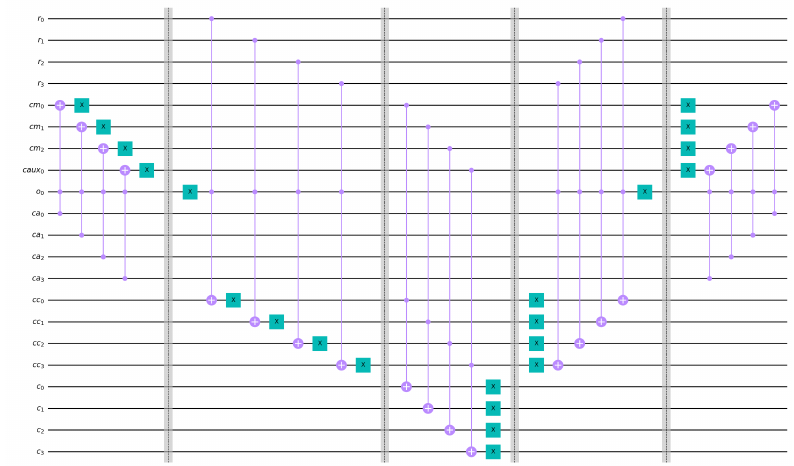
Figure 20. Selection circuit of expression (26), where the | ca (cid:105) qubits yield the computed y and | c (cid:105) stores the final output r (cid:48) . The last two sections of the circuit are uncomputing stages. The global quantum circuit for motion block, that comprises the above described computations, is shown in Figure 21.